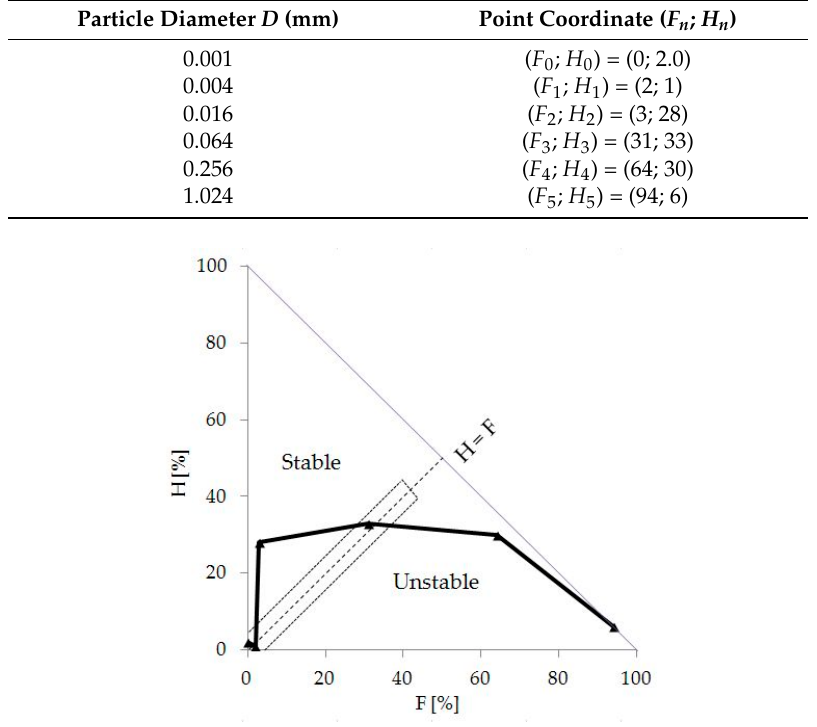
Figure 7. Internal stability of soil graphs according to Kenney and Lau (1985).